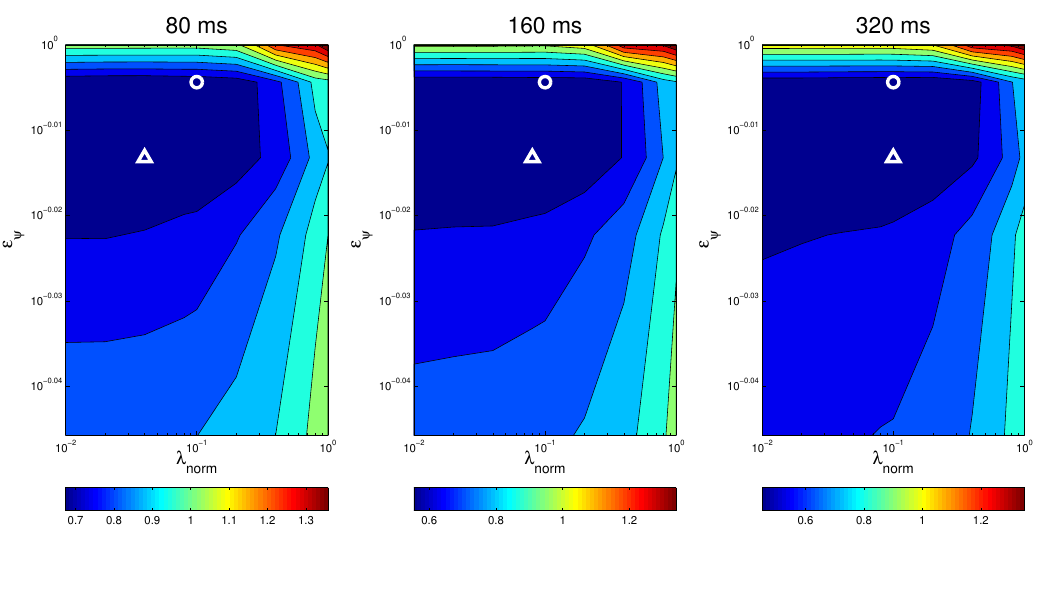
Figure 12. Optimization map for microphone setup B on sequence seq01 . The circle is the position of the best parameter combination in seq01 calculated for setup A and the triangle is the position of the best parameter combination in seq01 calculated for setup